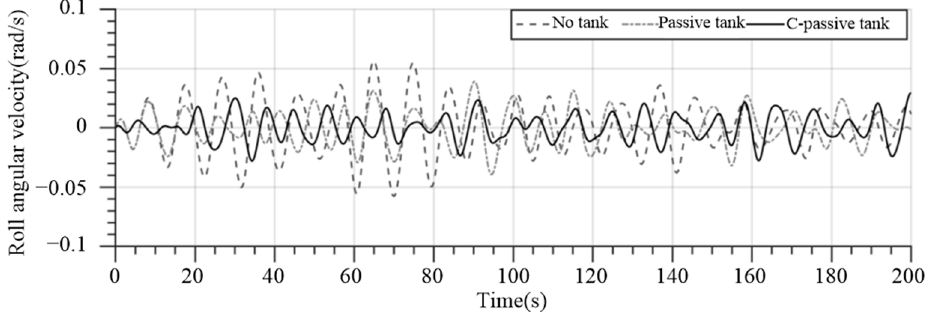
Figure 12. Roll angular velocity of no tank, passive anti-rolling tank, and controllable passive anti-rolling tank.